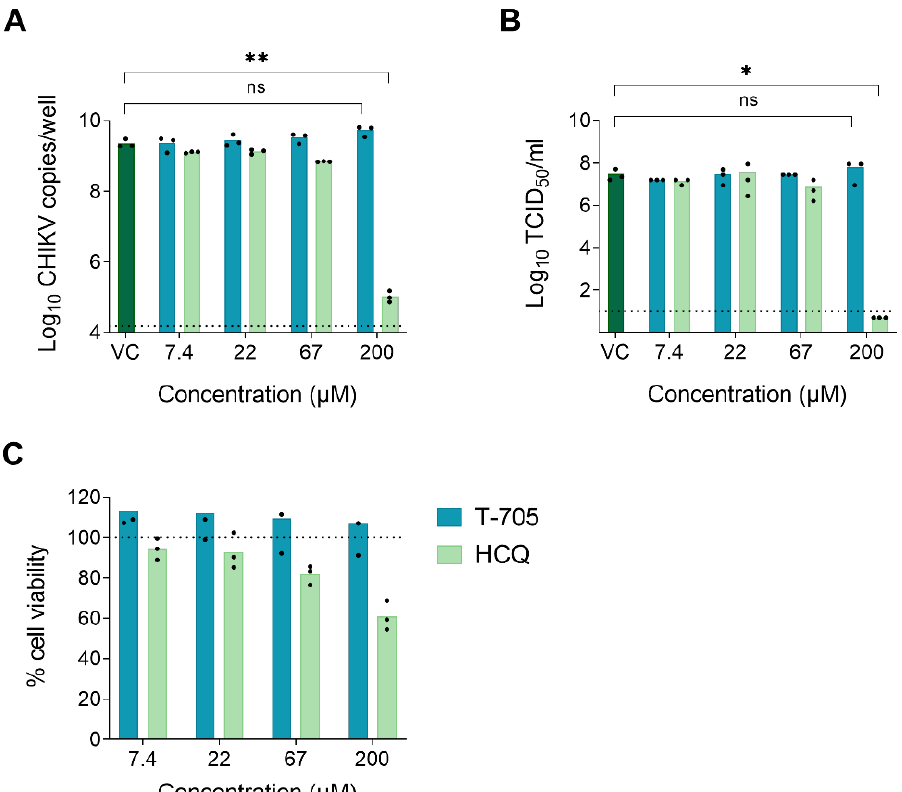
Figure 1. T-705 does not inhibit CHIKV in Aag2-AF5 cells. ( A ) Levels of intracellular viral RNA and ( B ) infectious virus progeny in the supernatant of Aag2-AF5 cells at day 3 post-infection following exposure to different compound concentrations. The dashed line represents the limit of detection. VC: Untreated virus control. ( C ) Compound-induced cytotoxic effects in Aag2-AF5 cells. The 100% cell viability indicates the absence of cytotoxic effects. Data shown are the results of at least two independent experiments; the bars show the mean value per condition. Statistically significant reductions in ( A ) CHIKV genome copies or ( B ) TCID 50 after treatment with different compound concentrations as compared to the VC, were analyzed using the Kruskal-Wallis test (* p < 0.05; ** p < 0.005).